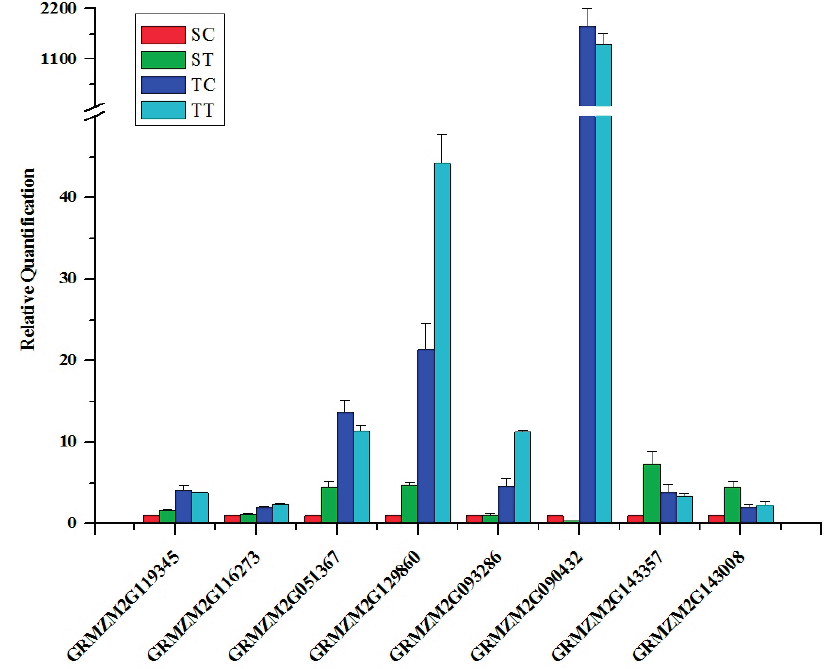
Figure 5. Real-time RT-PCR analysis for eight differentially expressed genes in nicosulfuron-tolerant and nicosulfuron-susceptible Zea mays . Real-time RT-PCR was carried out on three independent biological replicates each containing three technical replicates. The relative quantification of each transcript was normalized against β